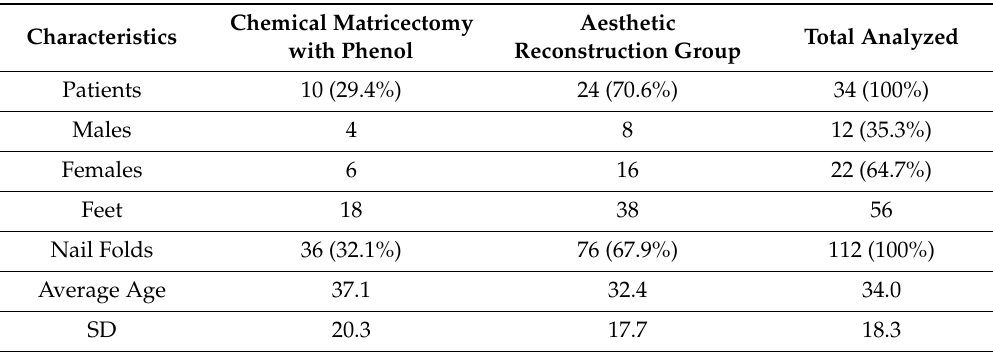
Table 1. Characteristics of the study sample by sex distribution.